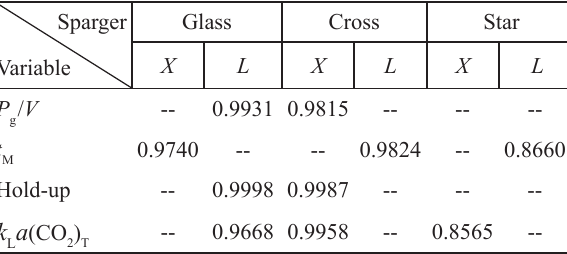
(a) and P (b) as a function of P X L the three